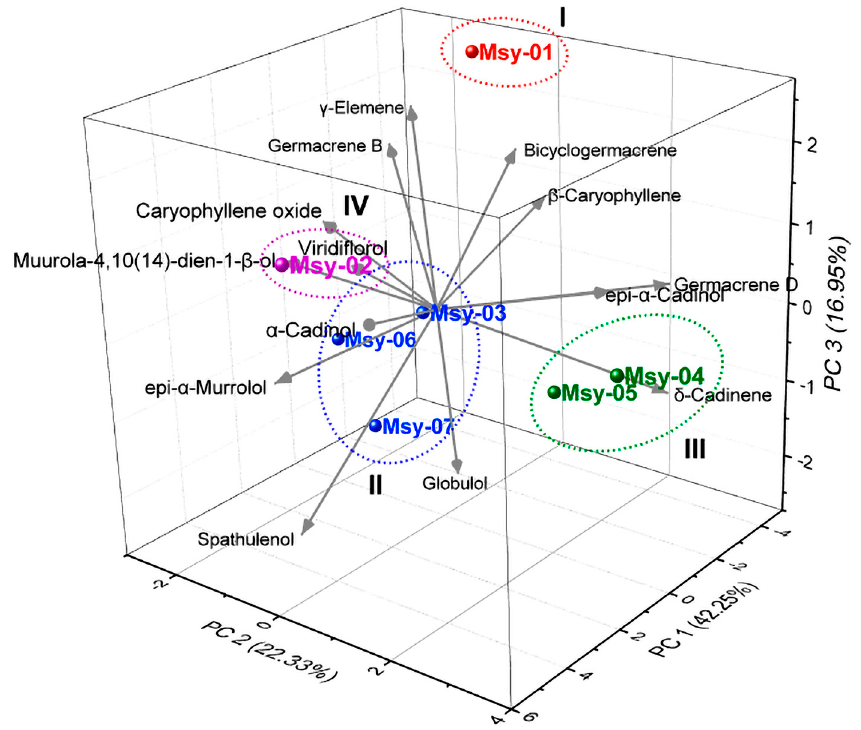
Figure 3. Principal components analysis of the oils of Myrcia sylvatica .